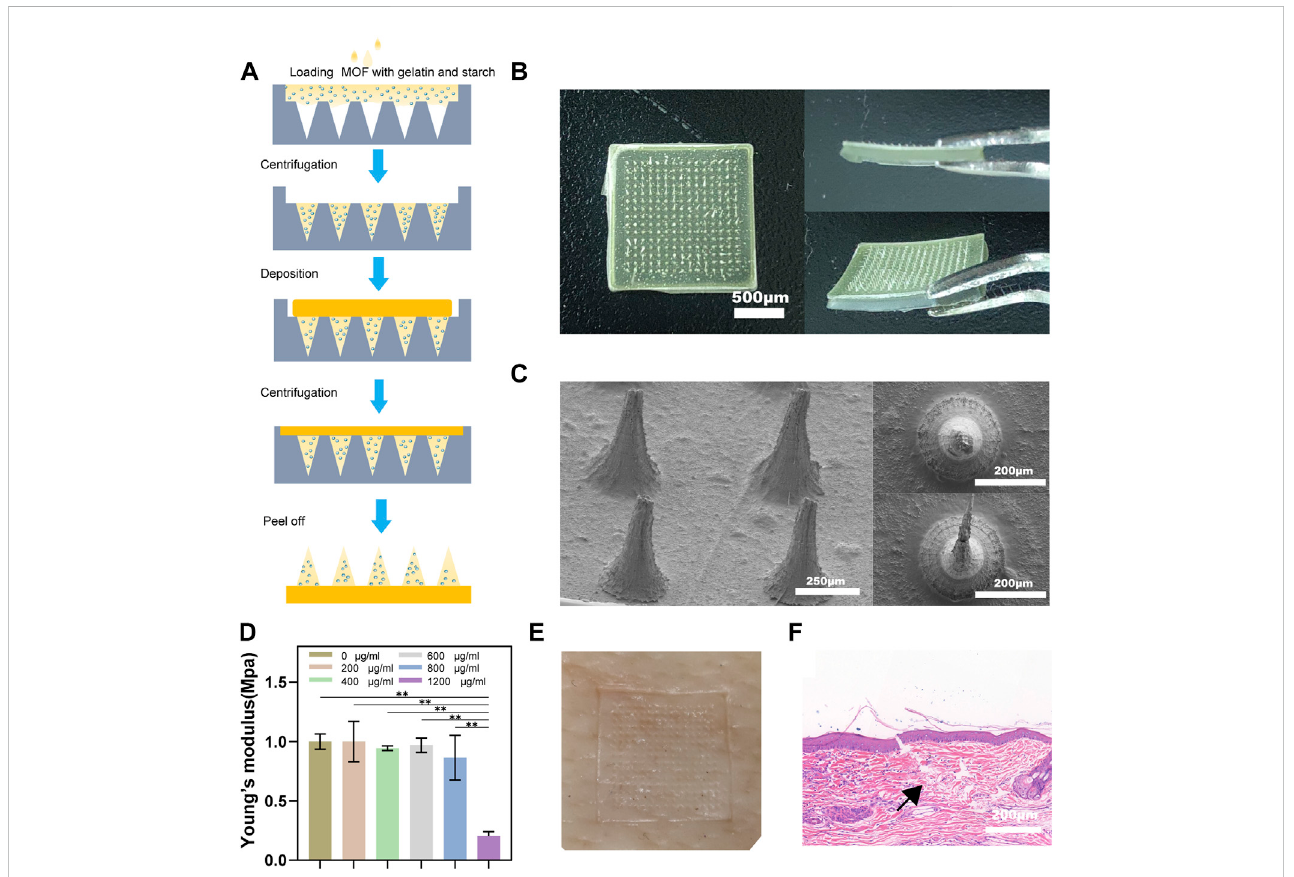
FIGURE 3 Morphology and mechanical properties of microneedle patches. (A) The schematic fabrication process of microneedle patches. (B) Optical images of microneedle patches, including a vertical view of a patch, and a cross-sectional view of a patch. (C) SEM images of microneedle patches with different magni fi cations. (D) Young ’ s modulus of MNs with different MOF concentrations. (E) After pressing the pig skin with the needle array, blue dye was rubbed on the skin. (F) H&E staining image of rabbit HS after insertion with MN patch. The black arrow indicates the broken stratum corneum of the